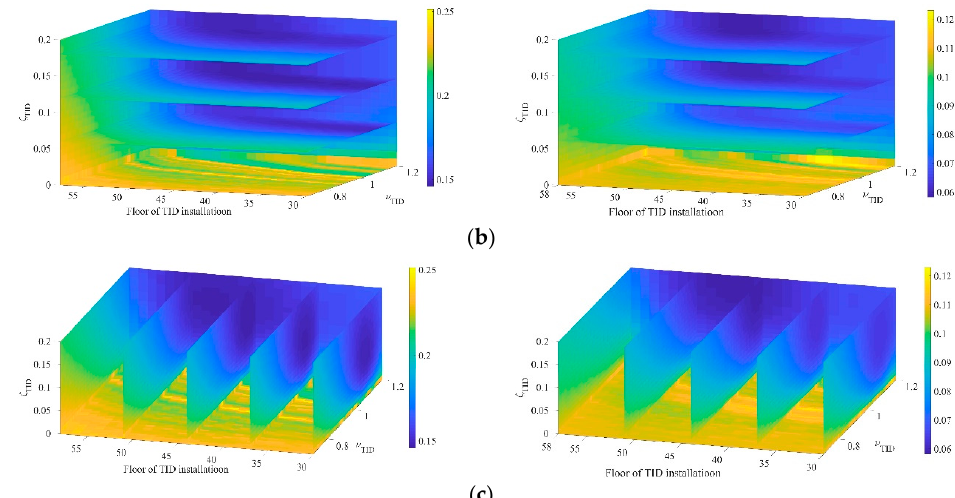
Figure 9. Peak acceleration at top floor of Tuned Inerter Damper (TID)-equipped structure at wind direction of 90 ◦ in the υ − ζ − t space. ( a ) Distributions of peak displacement ( left ) and acceleration ( right ) at constant frequency ratios ( υ = 0.7, 0.8, 0.9, 1.0, 1.1, 1.2). ( b ) Distributions of peak displacement ( left ) and acceleration ( right ) at constant damping ratios ( ζ = 6%, 12%, 18%). ( c ) Distributions of peak displacement ( left ) and acceleration ( right ) at constant floor of TMDI installation ( t = 30, 37, 44, 51, 58).